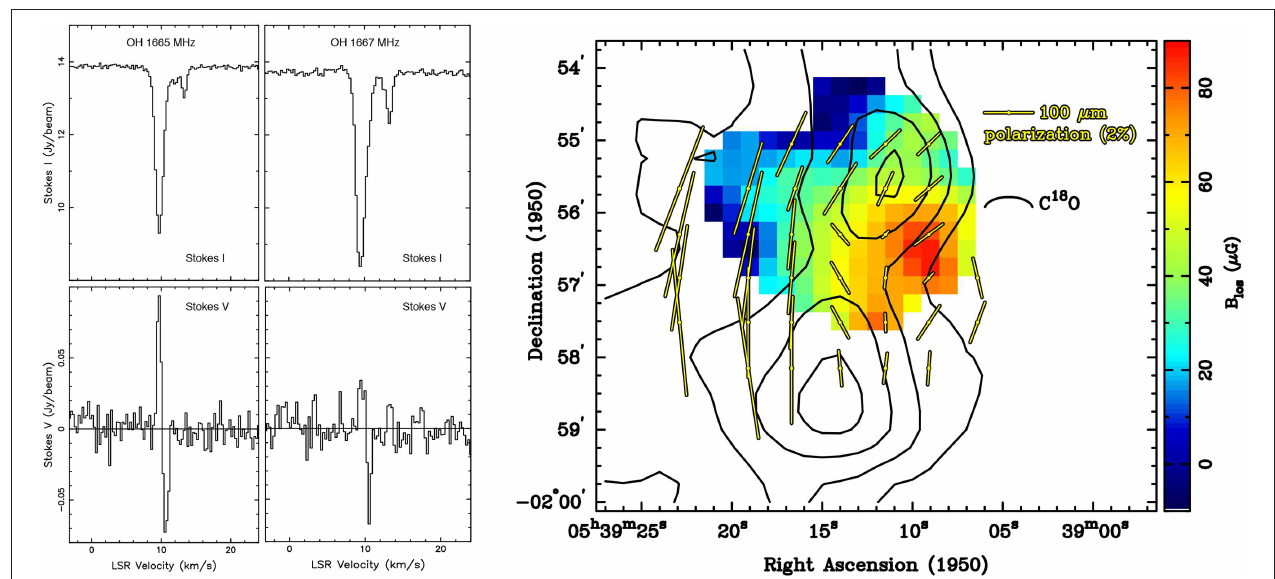
FIGURE 3 | Left : OH Zeeman Stokes I and V profiles toward NGC2024 at the peak B LOS position from VLA mapping (Crutcher et al., 1999a). Right : Map of B LOS (color) from OH Zeeman. Contours are C 18 O intensities and yellow line segments are dust polarization directions (Hildebrand et al., 1995). The magnetic field in the plane of the sky is perpendicular to the dust polarization, hence roughly along the minor axis of the molecular cloud defined by C 18 O (horizontal in the figure).